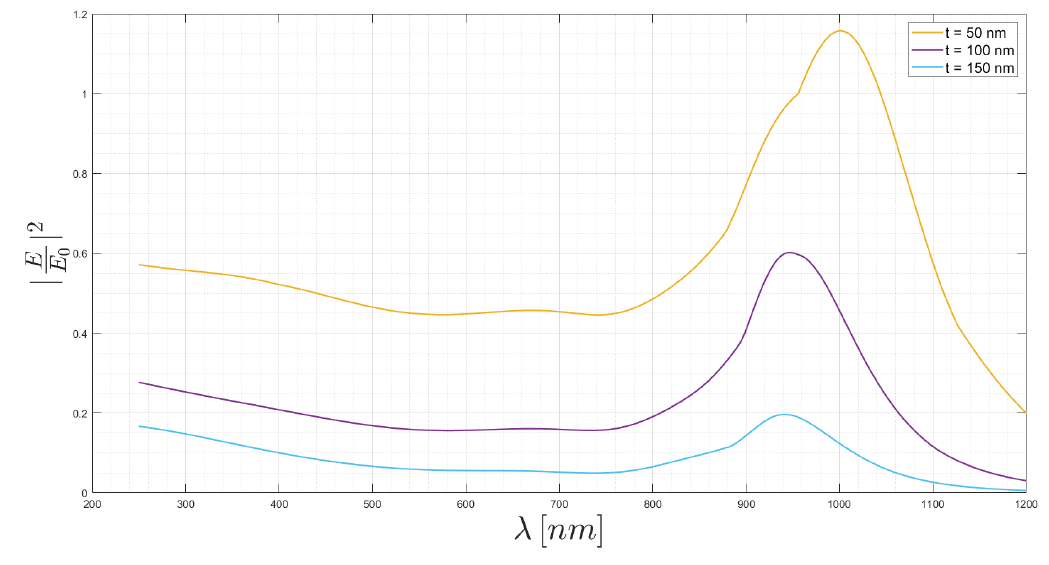
Figure 7. Nanoantenna thickness sweep on a gold nanostructure with a quartz substrate.